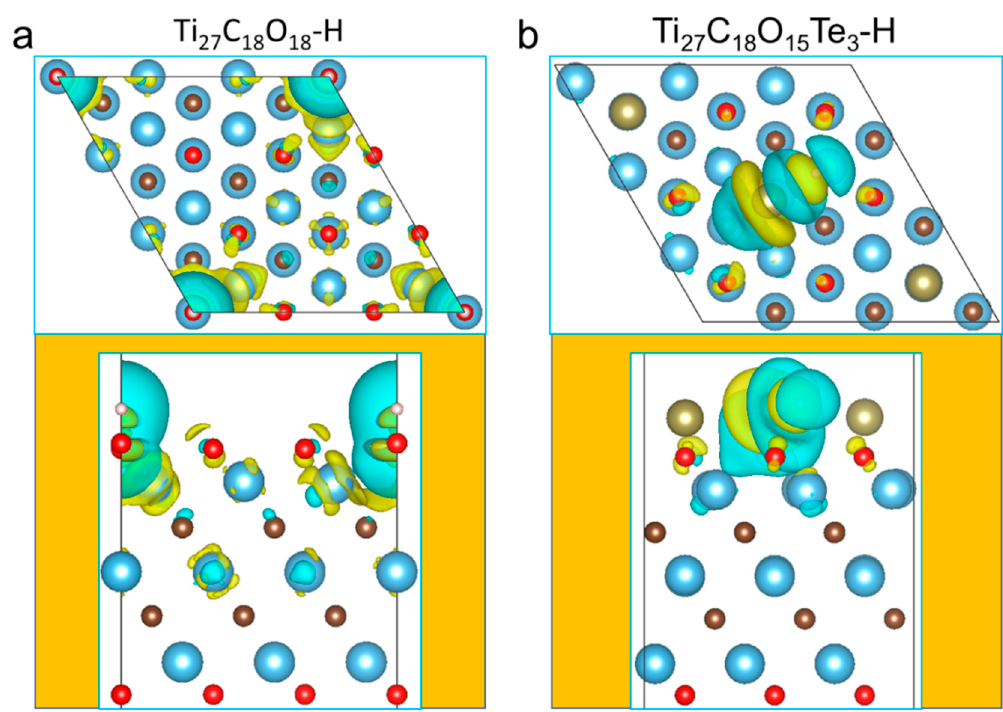
Figure 5. Difference charge density. ( a ) The different charge density maps of 2D-Ti 2 CO 2 after H adsorption; ( b ) the different charge density maps of Ti 27 C 18 O 17 Te 3 after H adsorbed.